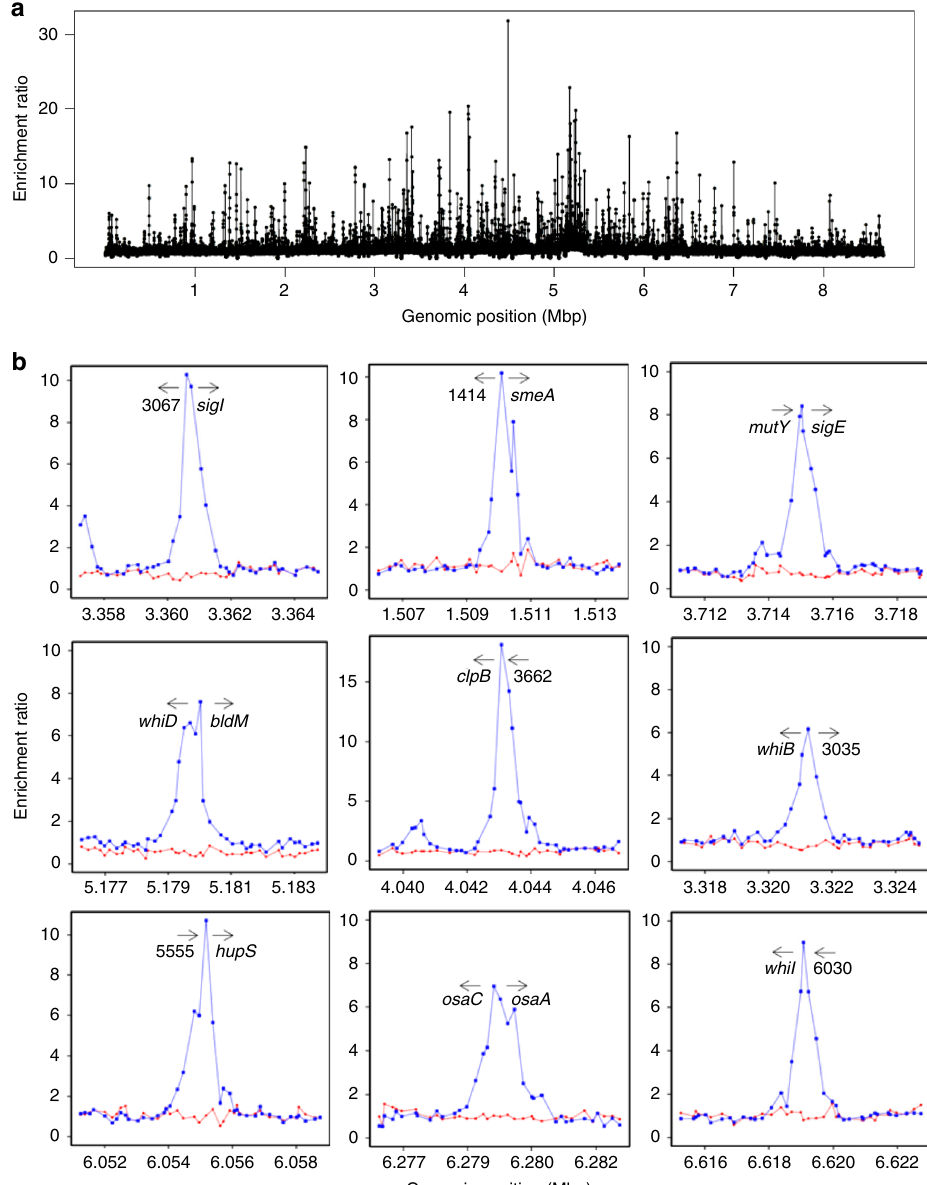
Fig. 1 The S. coelicolor BldC regulon. a Chromosome-wide distribution of BldC binding sites identi fi ed by ChIP-chip analysis. DNA obtained from immunoprecipitation of BldC was labeled with Cy3 and hybridized to DNA microarrays together with a total DNA control labeled with Cy5. Data are plotted as Cy3/Cy5 ratios ( y -axis), as a function of chromosome location ( x -axis). b ChIP-chip data for nine selected BldC targets in WT S. coelicolor and the S. coelicolor Δ bldC mutant (blue and red dots, respectively). Plots span approximately 8 kb of DNA sequence. Gene names or identi fi ers (SCO numbers) are indicated below the arrows, which indicate gene